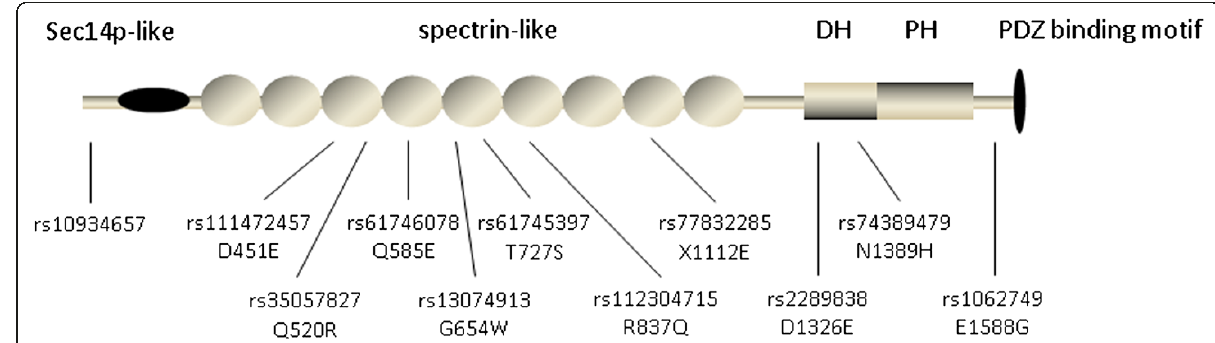
Figure 1 Domain structure of the kalirin gene, isoform 2. Dbl-homology (DH) and pleckstrin homology (PH) domains are responsible for